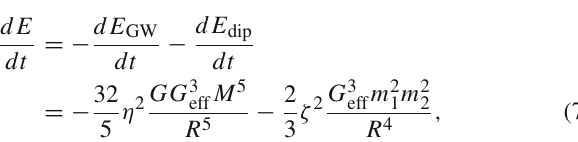
Fig. 1 The marginalized posterior probability distributions of chirp- mass of GW150914, with different high frequency cut-off f high = 50 , 100 , 200 , 400 , 600 , 800, and 1024 Hz. The uncertainty of the dis- tribution becomes larger as f high is less than 400